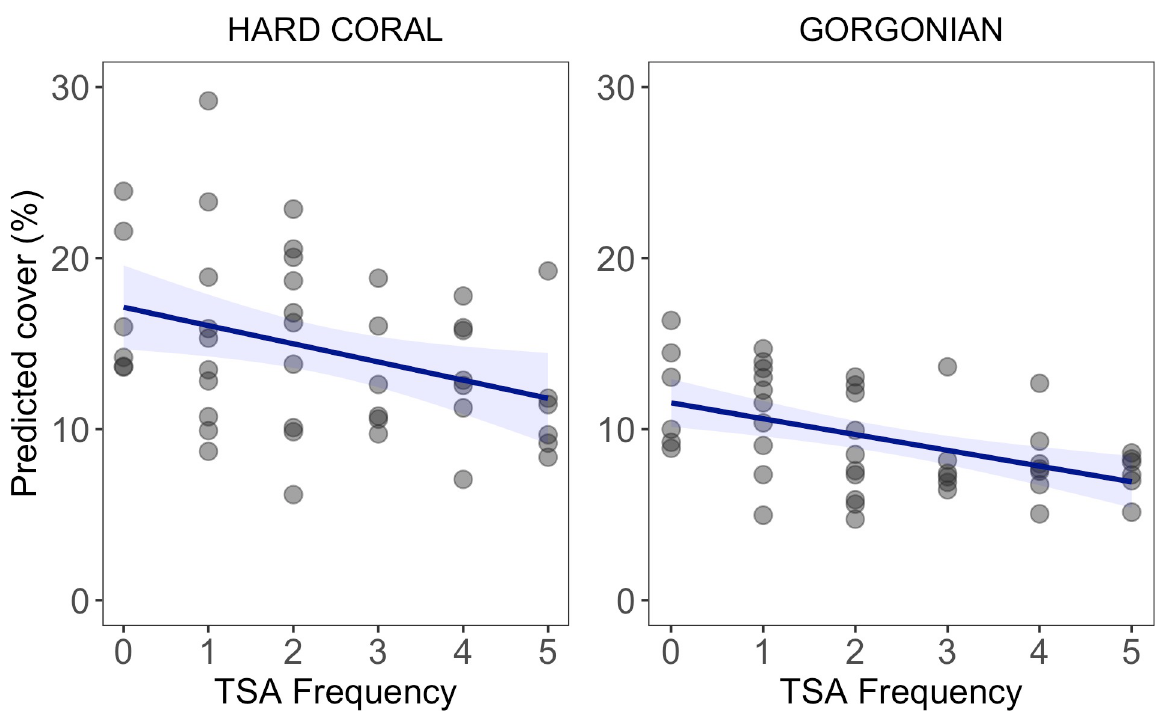
Fig 4. Effect of TSA frequency on hard-coral and gorgonian cover. Points are predicted benthic-group cover (back-calculated from logit transformation) from a Bayesian generalized liner mixed model accounting for time, protection status, and HII. Blue lines are the fitted curves of the models and shaded areas are the 95%